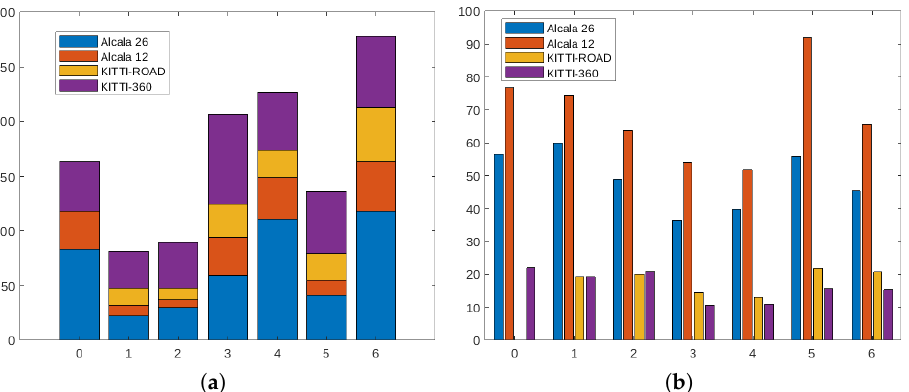
Figure 4. Distribution of intersection types by the seven considered road configurations (0–6) ( a ) and sequence length ( b ) for KITTI, KITTI-360, and the two sequences of our Alcalá de Henares